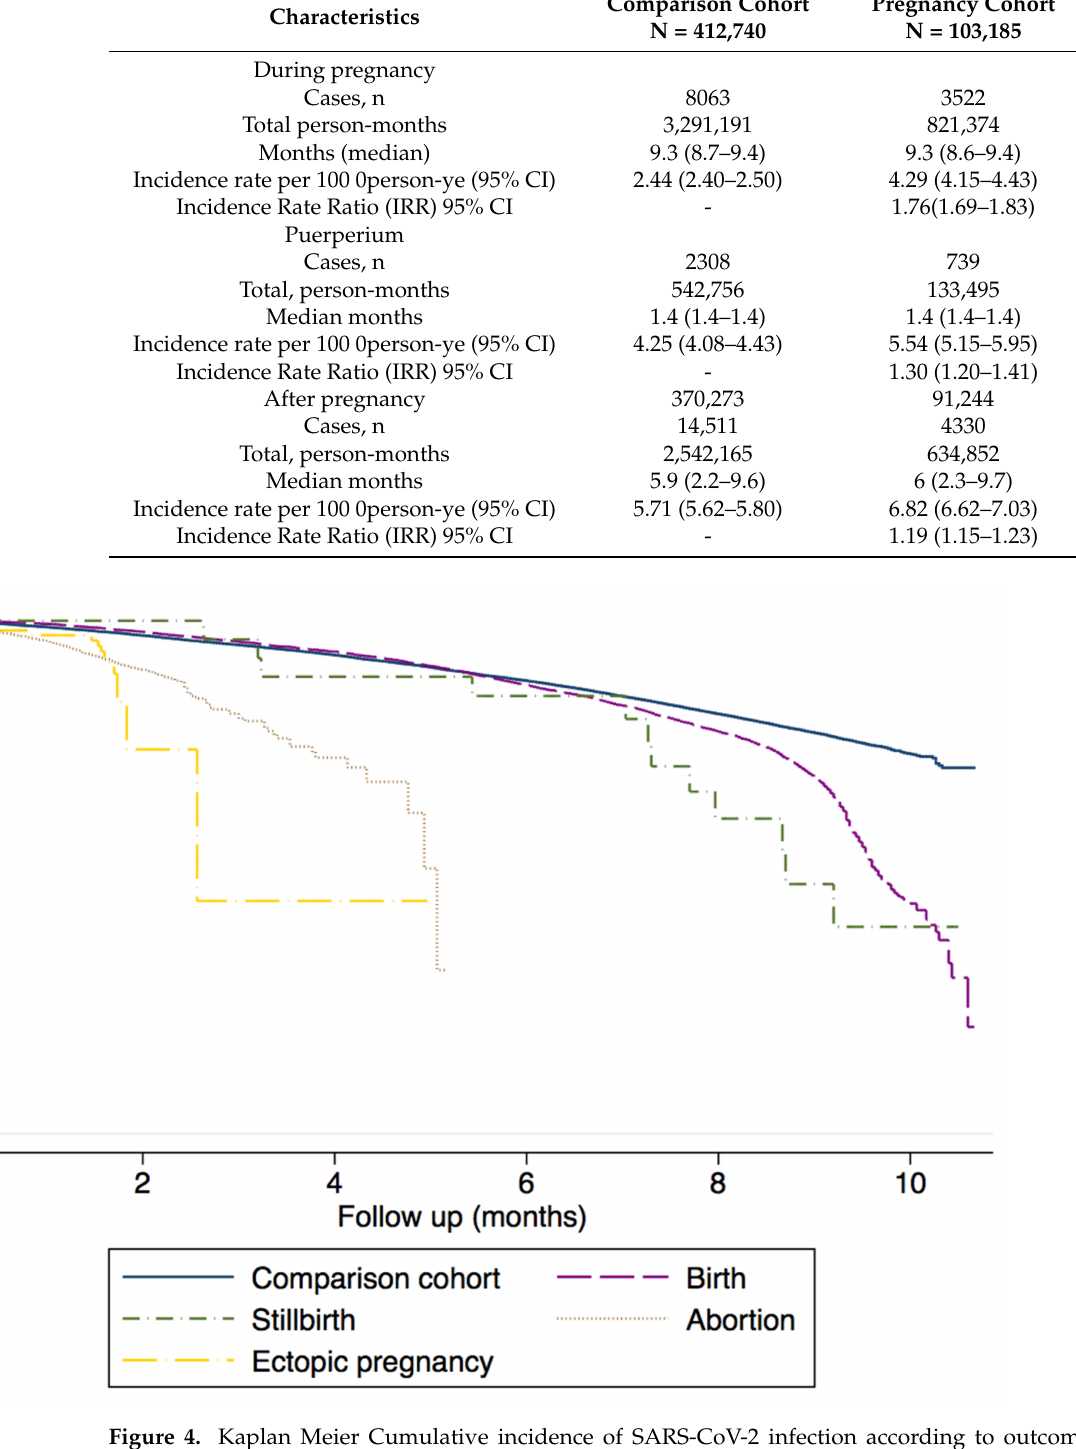
Figure 4. Kaplan Meier Cumulative incidence of SARS-CoV-2 infection according to outcome of